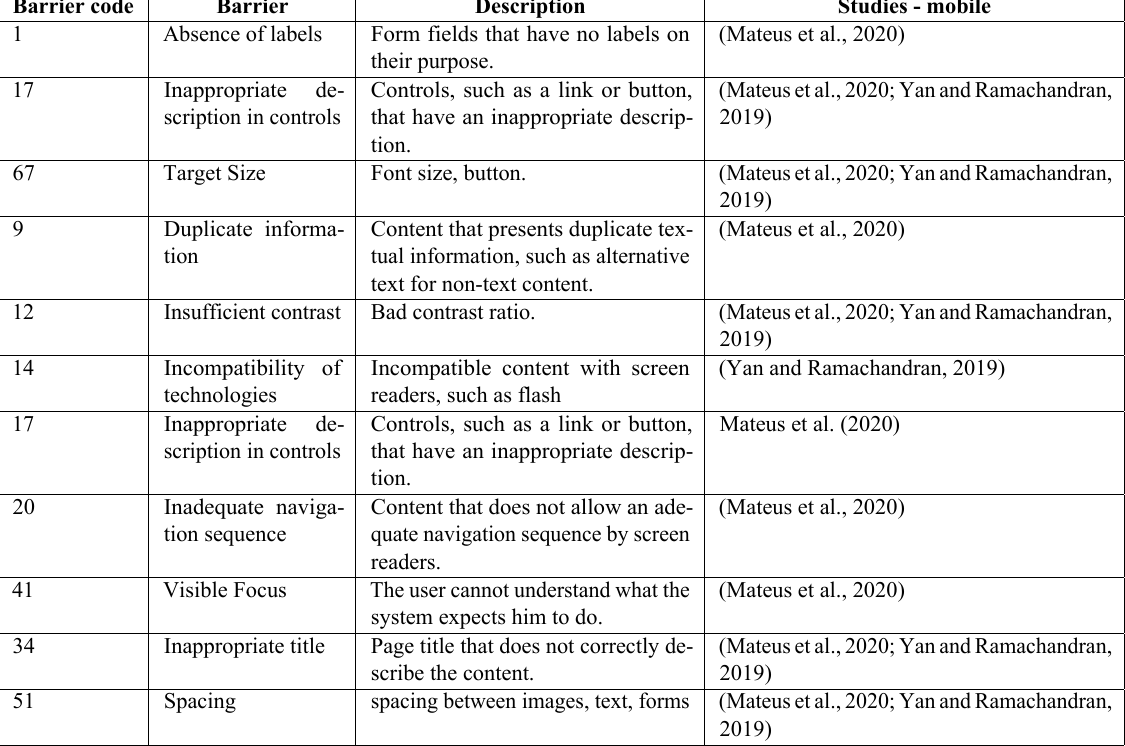
Table 11. Accessibility problems encountered by automated evaluation tools on mobile applications Barrier